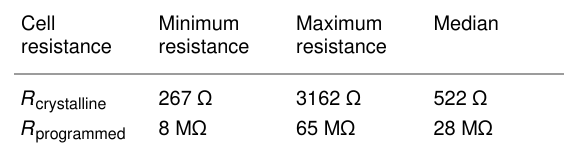
Table 1: Statistical distribution of cell resistance values. Minimum, maximum, and median of the crystalline and programmed resistance values ( R crystalline and R programmed ) of the 25 measured GST cells ( L GST ≈ 470 nm, W GST ≈ 130 nm, and t GST ≈ 50 nm). Cell